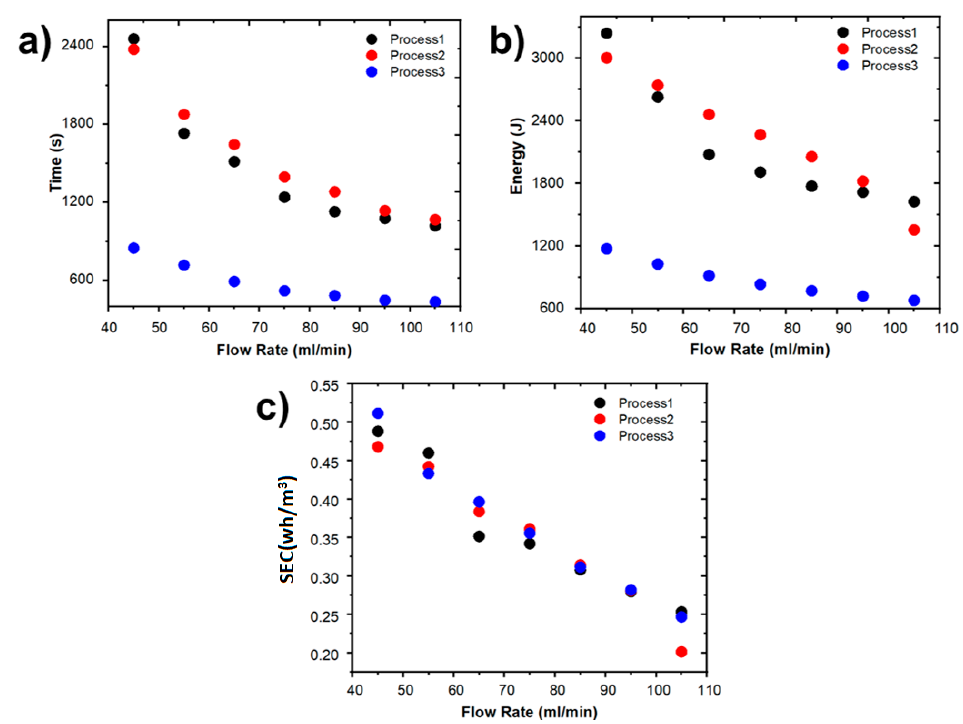
Figure 7. ( a ) Time, ( b ) energy, and ( c ) SEC for the three types of processes as a function of flow rate (NaCl 0.4 M,